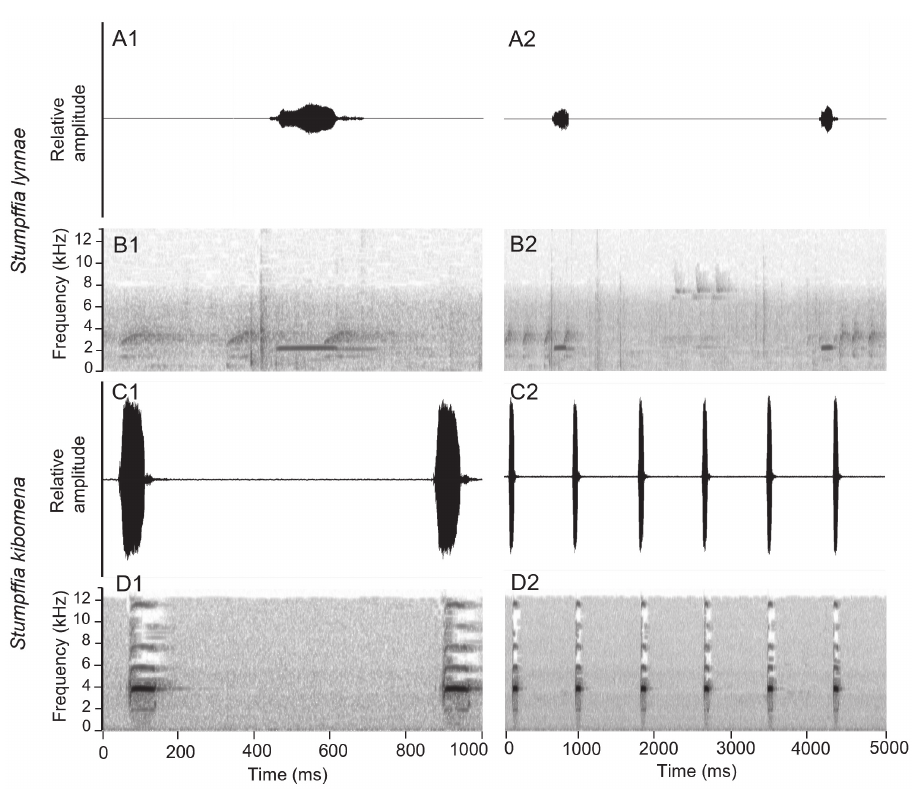
Figure 4. Male advertisement call of S. lynnae sp. nov. A oscillogram B spectrogram. S. kibomena C oscil- logram D spectrogram over a one-second interval (column 1) and a five-second time interval (column 2). Table 2. Acoustic traits of Stumpffia kibomena in comparison to those of S. lynnae sp. nov. Species and